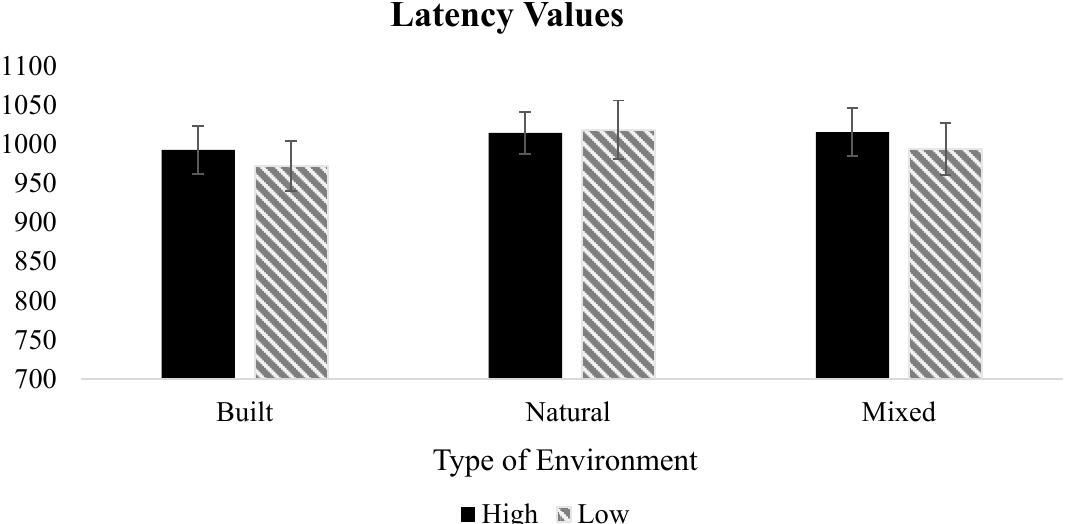
Figure 2 . Effect of environmental settings (built/natural/mixed) and level of mystery (high/low) on PRS scores. Error bars represent the standard error of the mean PRS scores.